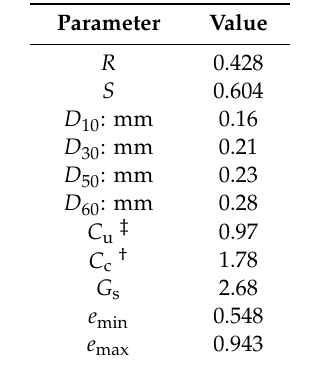
Table 1. Grading, packing and shape parameters for F161 sand.